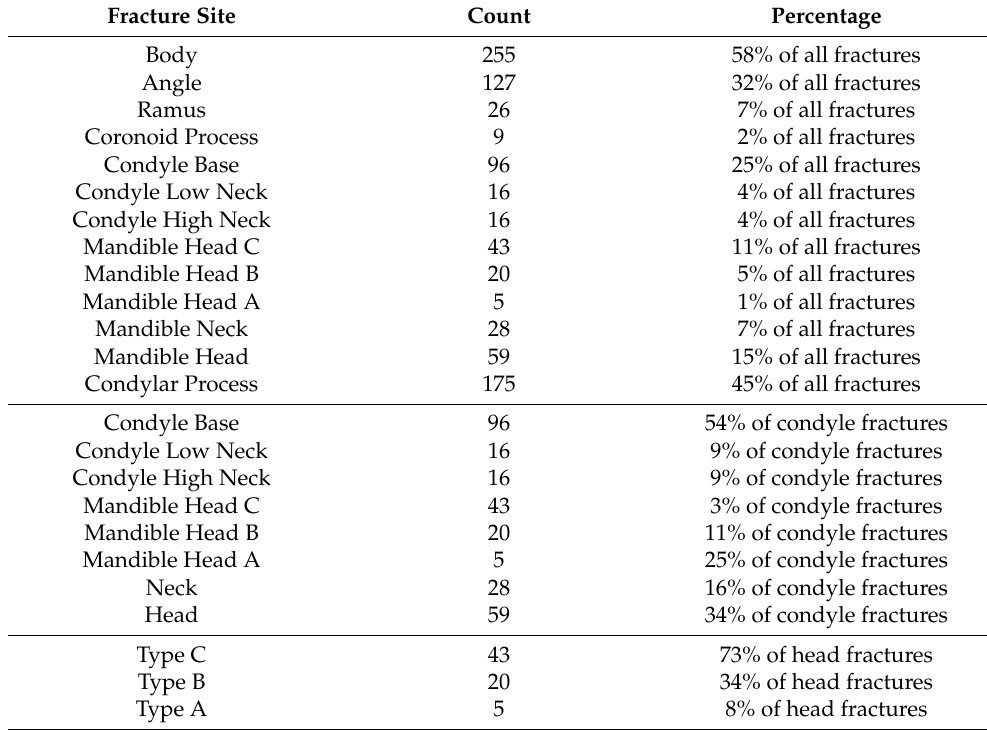
Table 2. Frequency of mandible